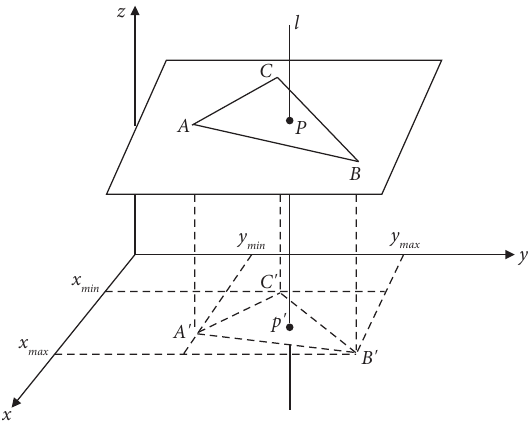
Figure 8: Te intersection of the trigonometric element ABC and FDTD grid lines.